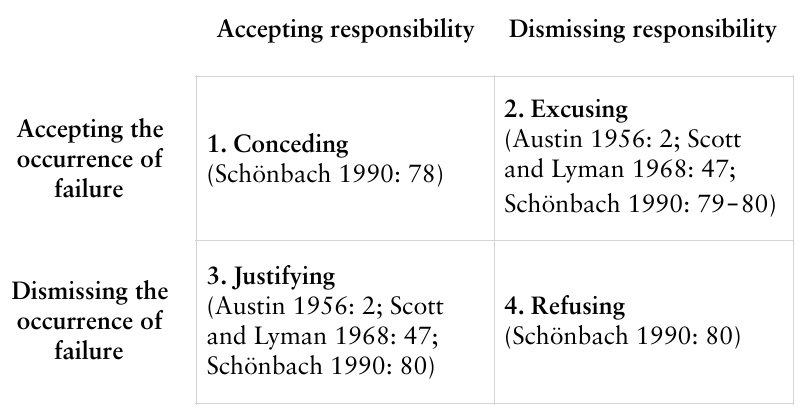
Table 1. Four ways of dealing with rejection as